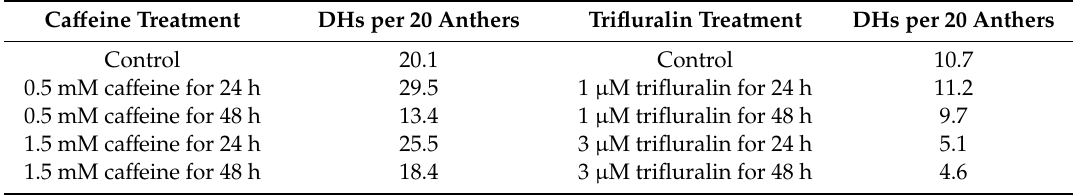
Table 5. Success index, expressed as DHs per 20 anthers, following ca ff eine treatment on the (Yr57 / 3*Gladius#60) / 2*Trojan cross and trifluralin treatment on Tammarin